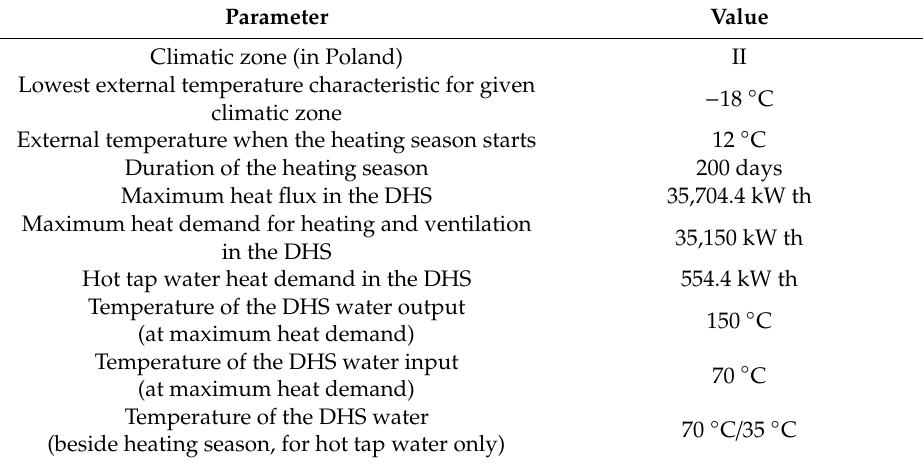
Table 3. Main parameters of the Koło district heating system